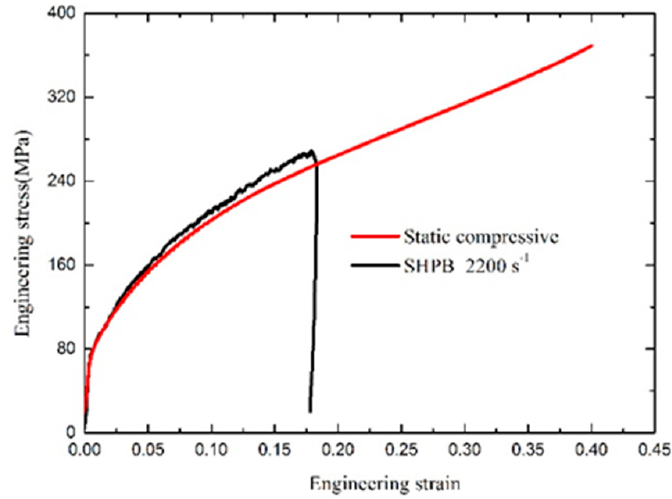
Figure 3. Static (red) and dynamic (black) engineering stress–strain curves of 3A21 aluminum alloy.